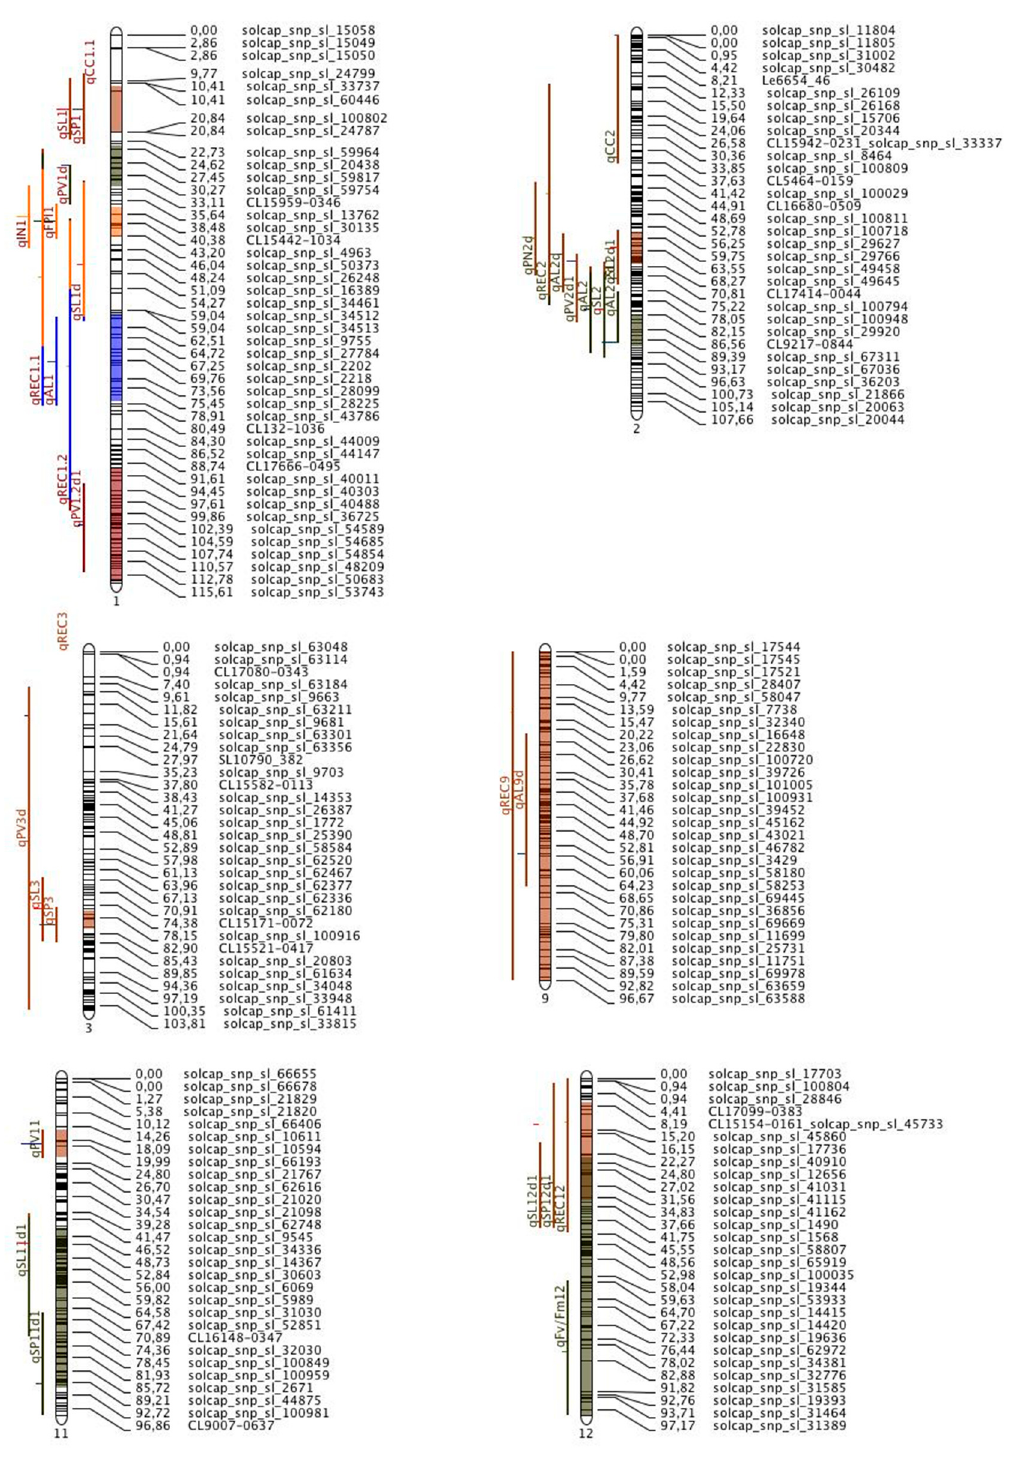
Figure 2. Projection of Meta QTL on consensus map. Legend: The MQTL are represented by di ff erent colors on the chromosomes while QTL are represented by vertical bars. QTL having the same color as MQTL belong to this MQTL. A given QTL can belong to two or more